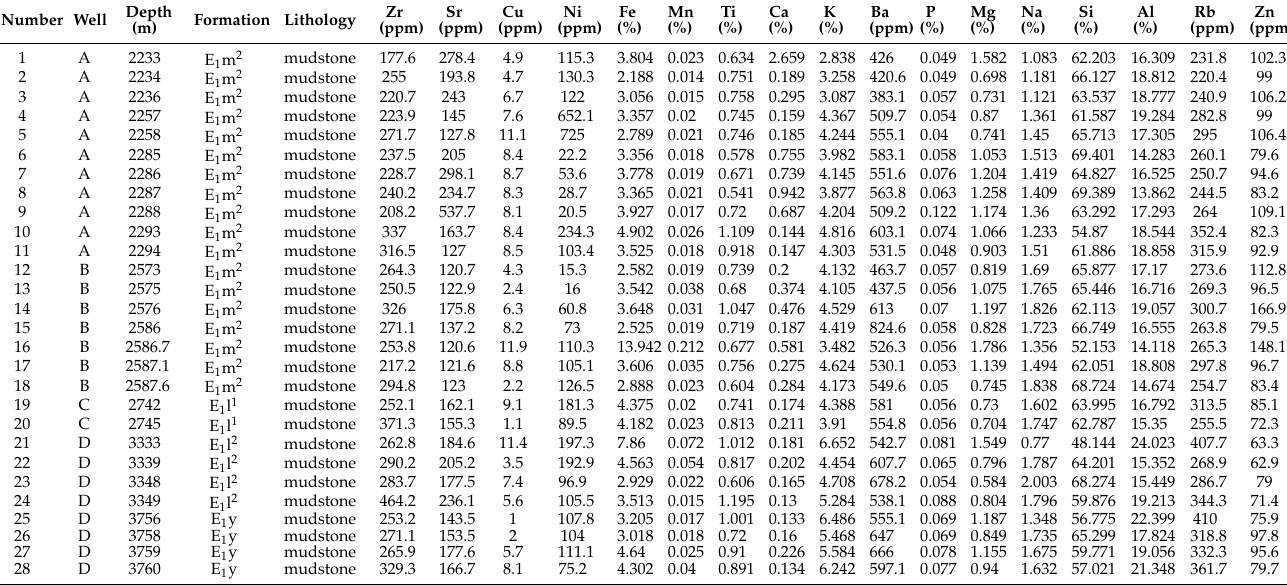
Table 1. The elemental contents in the West Lishui